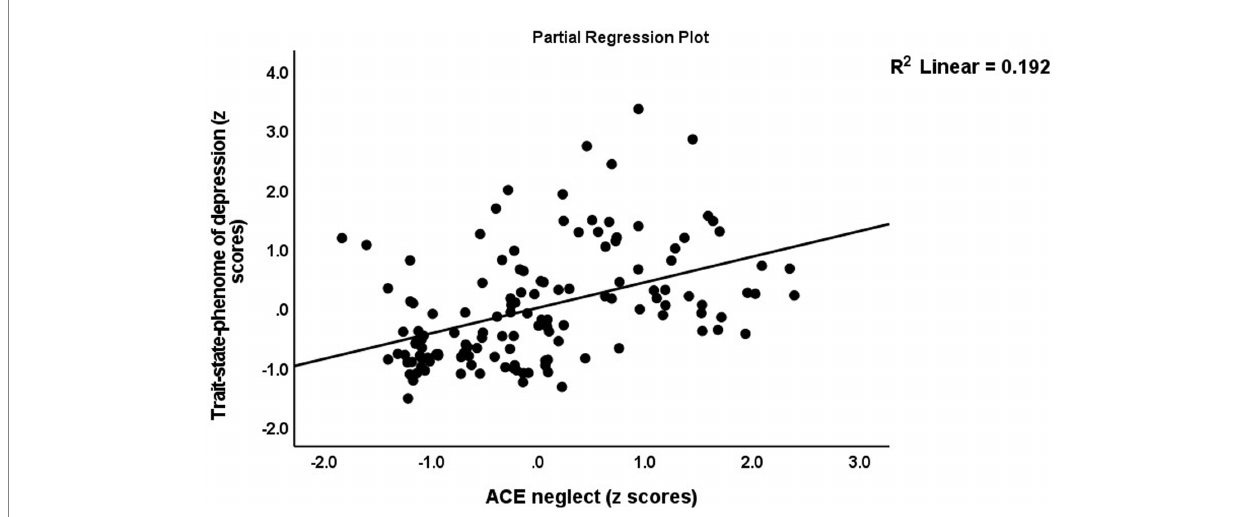
FIGURE 1 Partial regression of the trait–state phenome on neglect adverse childhood experiences (ACE).